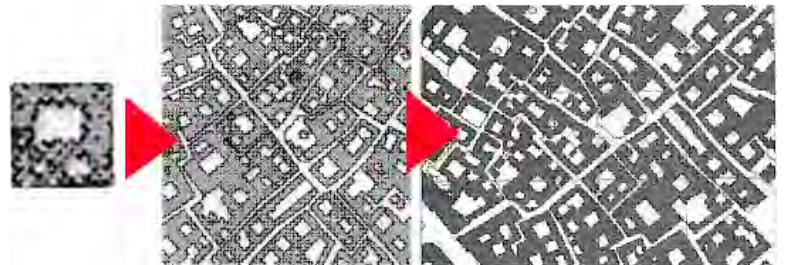
Figure 6. Hierarchy, unity and diversity in the urban fabric of the Islamic city